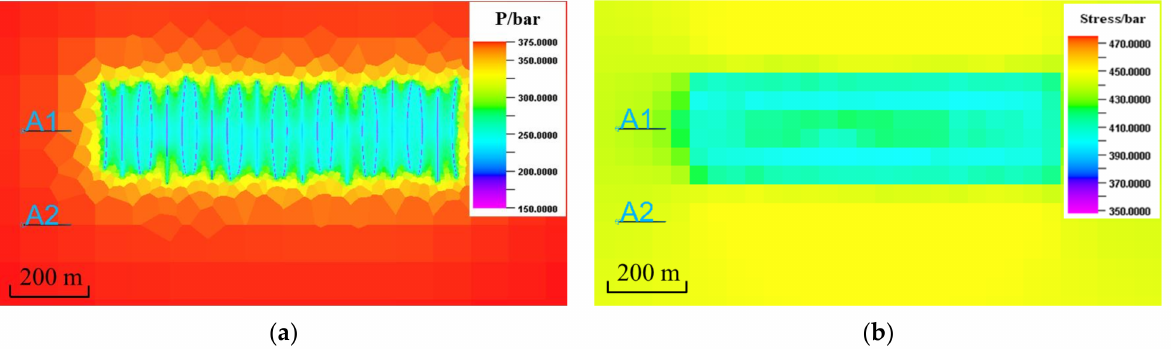
Figure 12. Distribution of: ( a ) pressure; ( b ) stress.